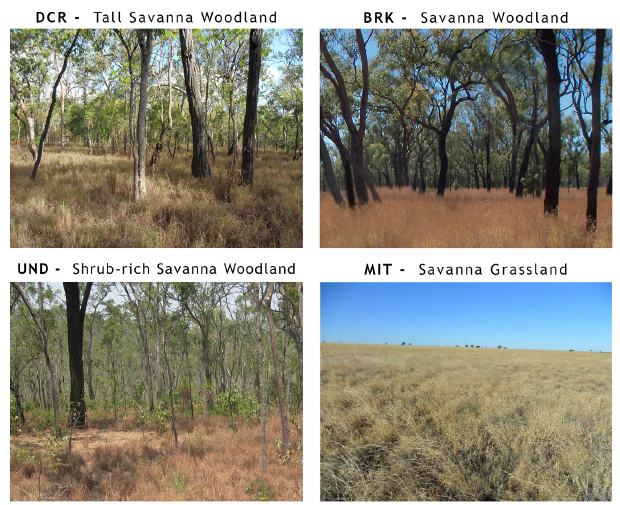
Figure 2. Characteristics and regional classification of the vegeta- tion; the reader is referred to Torello-Raventos et al.